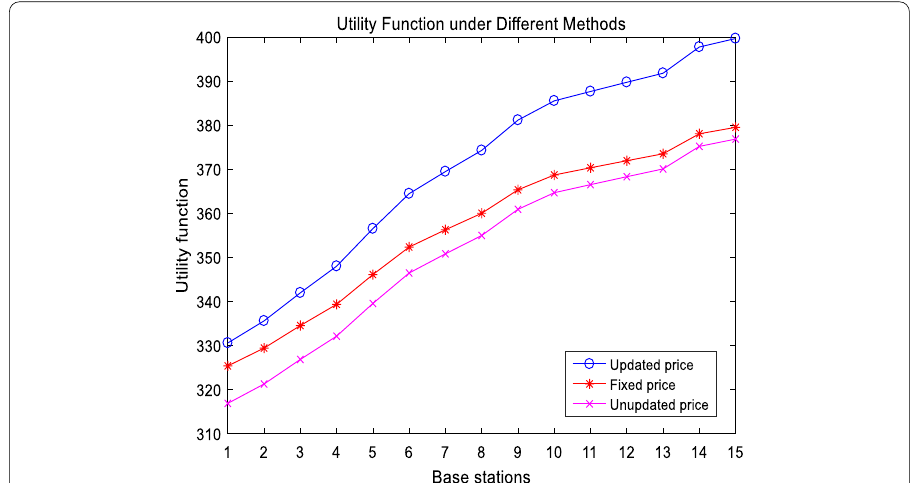
Fig. 5 Utility function under different methods. The blue curve represents the utility function in the updated-price